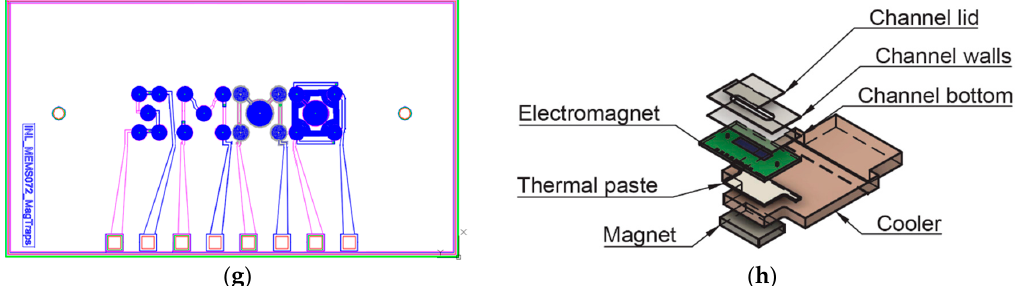
Figure 5. ( a – f ) Layout of MEMT configurations, S: S-configuration; M: M-configuration, C: Central, R: Reversed, L: Large central coil, I: Inter-windings, N: Near, F: Far. The current in the central coil is opposite to that in the external coils as indicated by the arrows. The distance between the center of the central coil and the center of the external coils is 0.99 mm for SCR and SCRL whereas for the others is 1.2 mm; ( g ) schematics of one die with 4 different MEMT configurations. From left to right: SCR, MCR, MCRL, CRIF; ( h ) schematics of the MEMT mounting: Permanent magnet, copper microchannel cooler and microfluidic channel for bioflow.